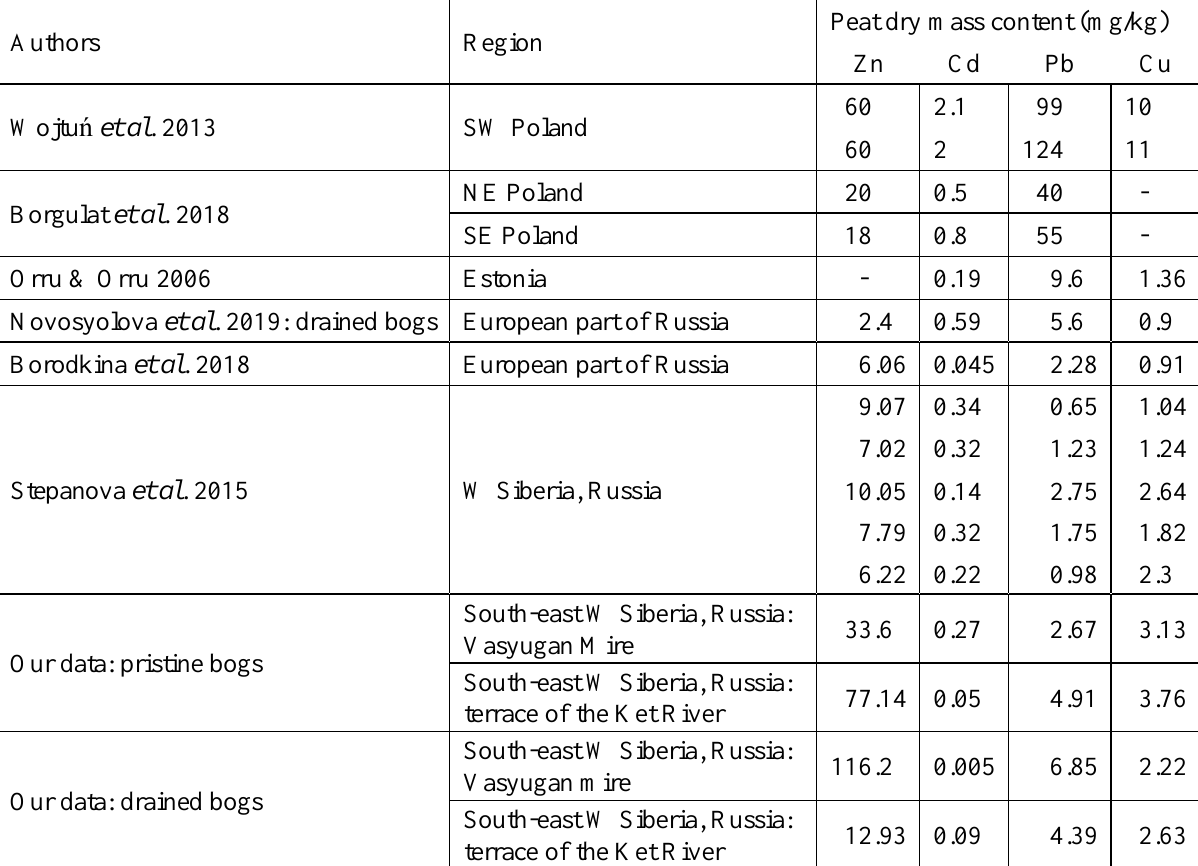
Table 3. Element content of dry peat, according to different